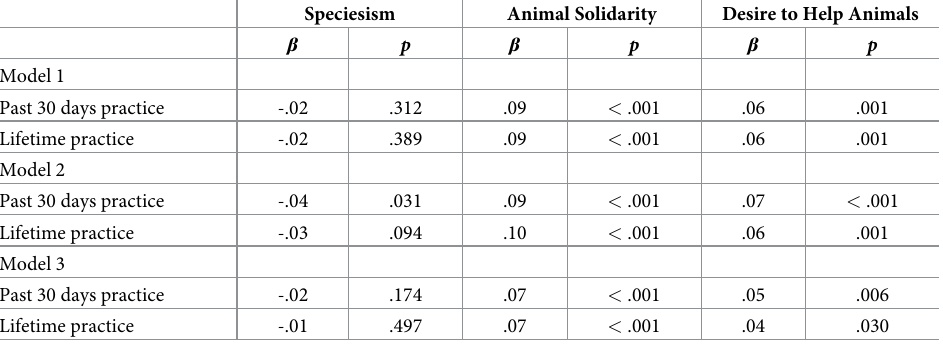
Table 1. Loving-kindness or compassion meditation practice and human-animal